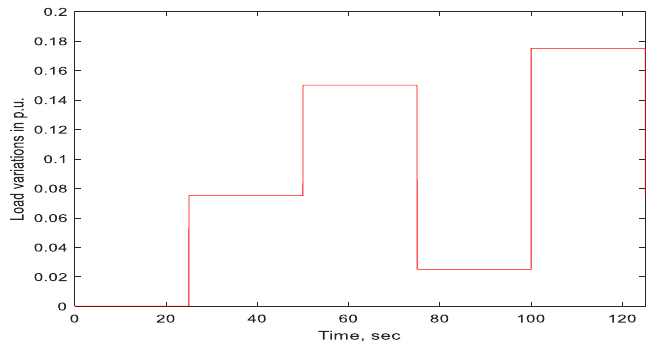
Figure 12. Multiple load profile variations.